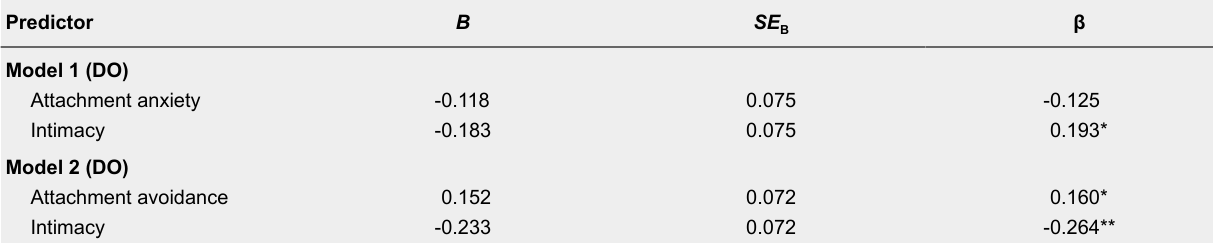
Regression Coefficients of Predictor Variables on Breakup Strategies